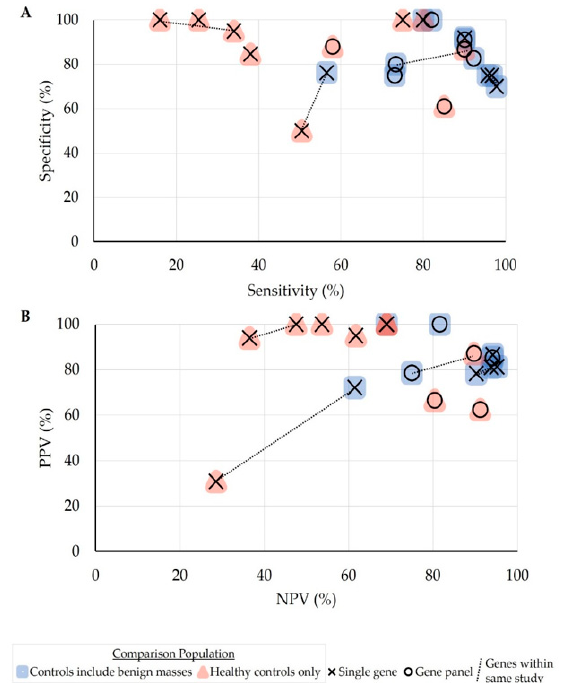
Figure 2. Diagnostic performance of targeted genes in differentiating ovarian cancer from controls by ( A ) sensitivity and specificity or ( B ) positive predictive value (PPV) and negative predictive value (NPV). Data points depict separate gene comparisons. Colored shapes represent the control population used in each comparison: Healthy patients plus those with benign masses (blue squares) or healthy patients only (red triangle). Symbols represent whether a single gene (X) or multiple genes (O) were included in the methylation panel. Lines connect genes that were evaluated in the same